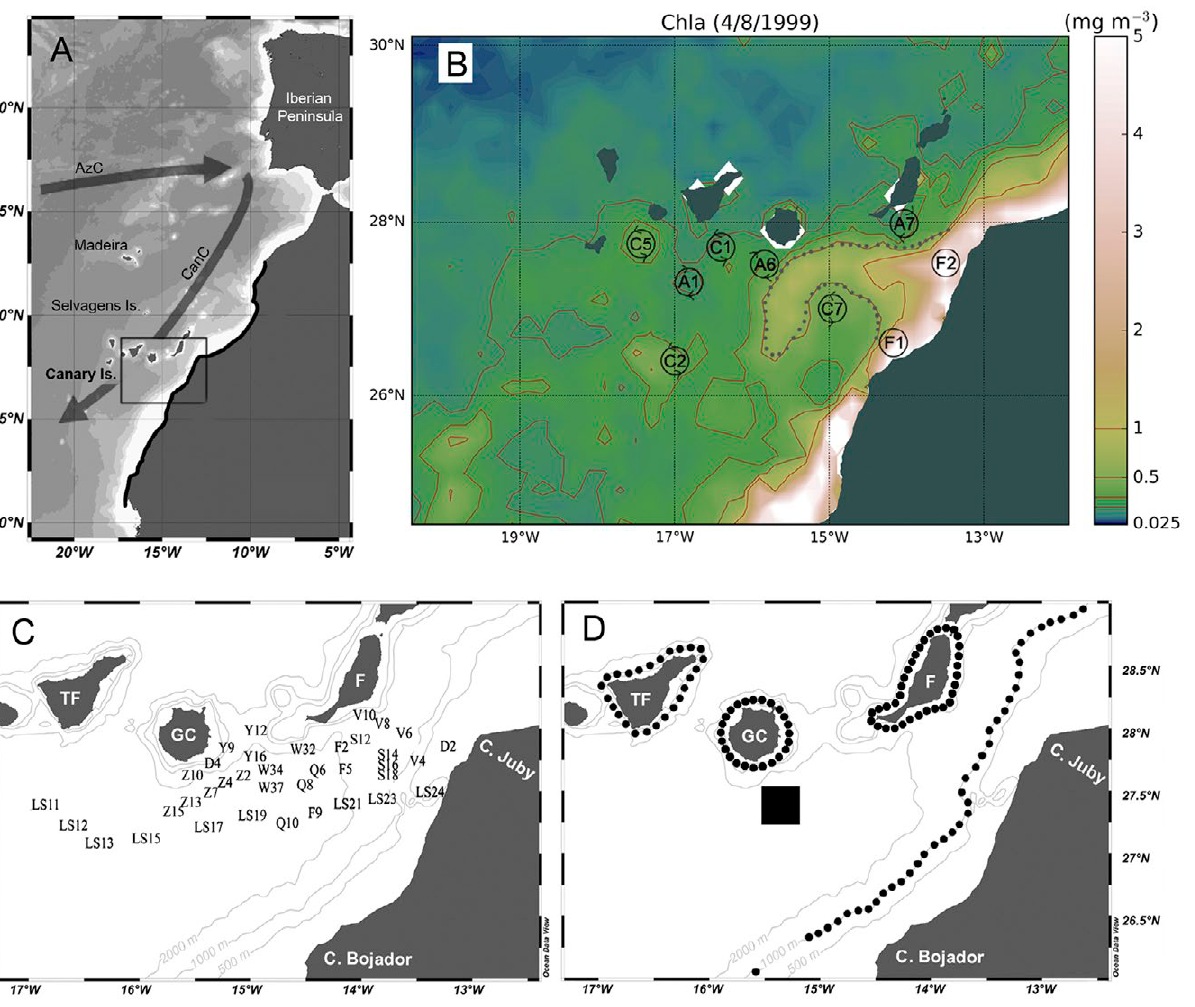
Fig. 1. – Map of the study area off the NE Atlantic region. A, the principal currents of the eastern subtropical gyre are shown: Azores Current, AzC; Canary Current, CanC. B, SeaWIFS satellite chlorophyll image of highlighting the mesoscale oceanographic structures described by Barton et al. (2004) (C, cyclonic eddy; A, anticyclonic eddy; F, filament; dotted grey line, filaments location). C, location of CTD + LHPR sampling stations. D, schema of the experimental design for the transport simulations (dotted lines, potential release zones; black square, target area). The islands of Tenerife (TF), Gran Canaria (GC) and Fuerteventura (F) are identified in the